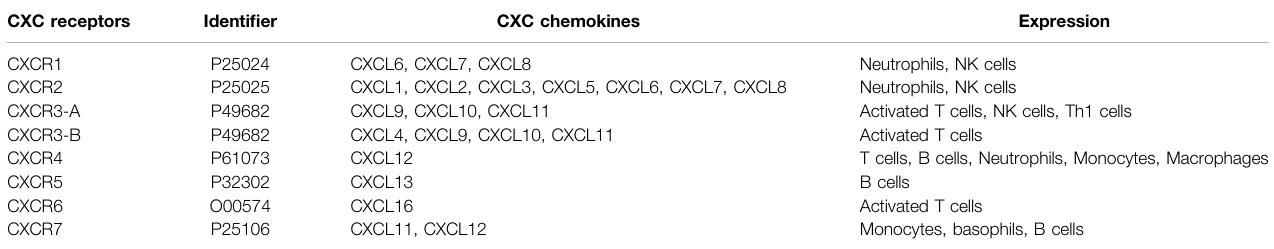
TABLE 1 | Human CXC Receptors and their cognate ligands (Bateman et al., 2021). CXC